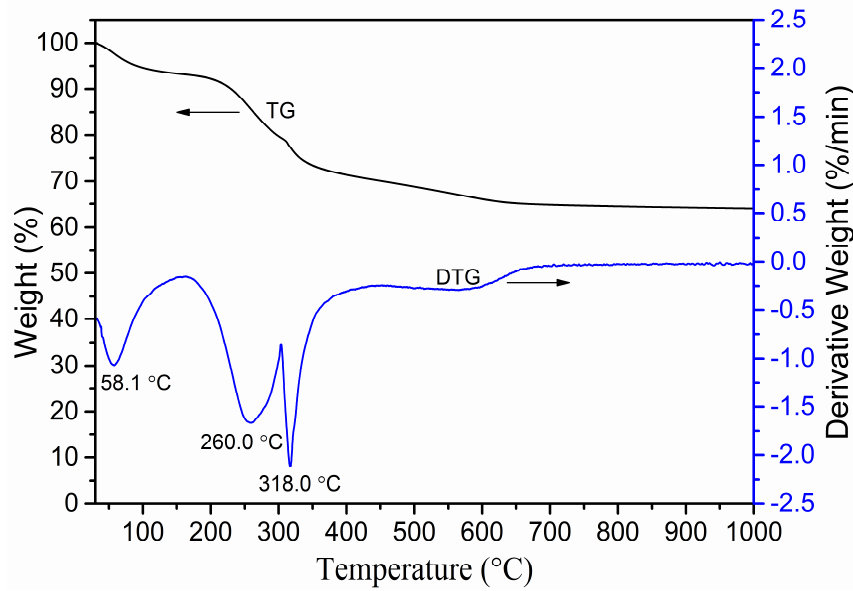
Figure 5. Thermal gravity and differential thermal gravity (TG–DTG) curves of as-synthesized samples (ASSs) with a heating rate of 10 °C/min.